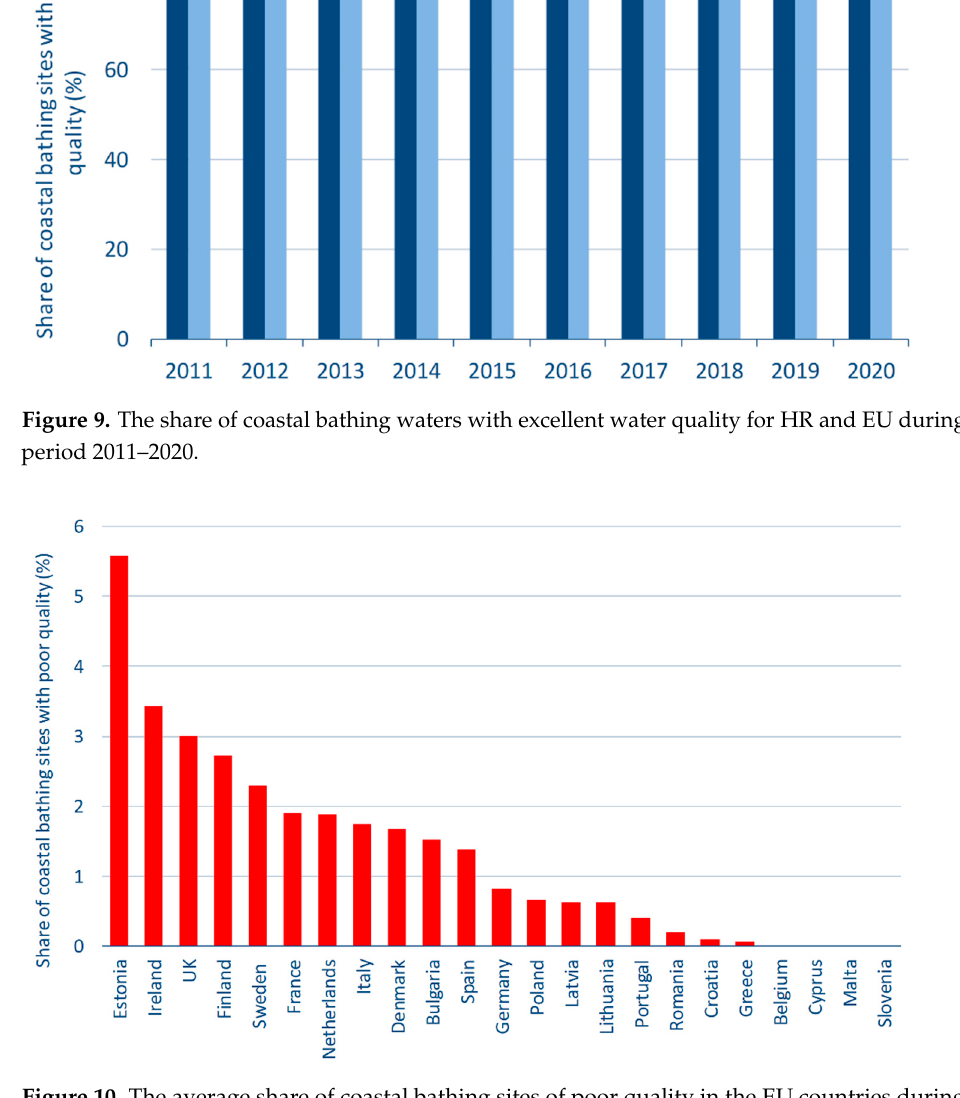
period 2011–2020.